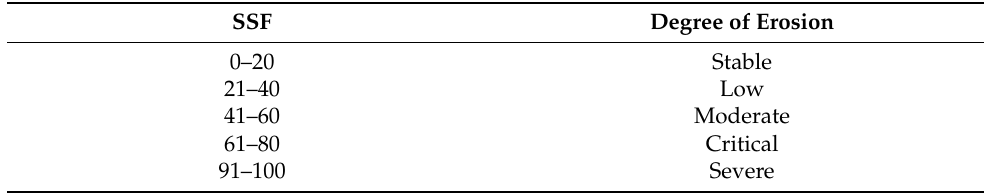
Table 2. Degrees of erosion as a function of the soil surface factor (SSF)